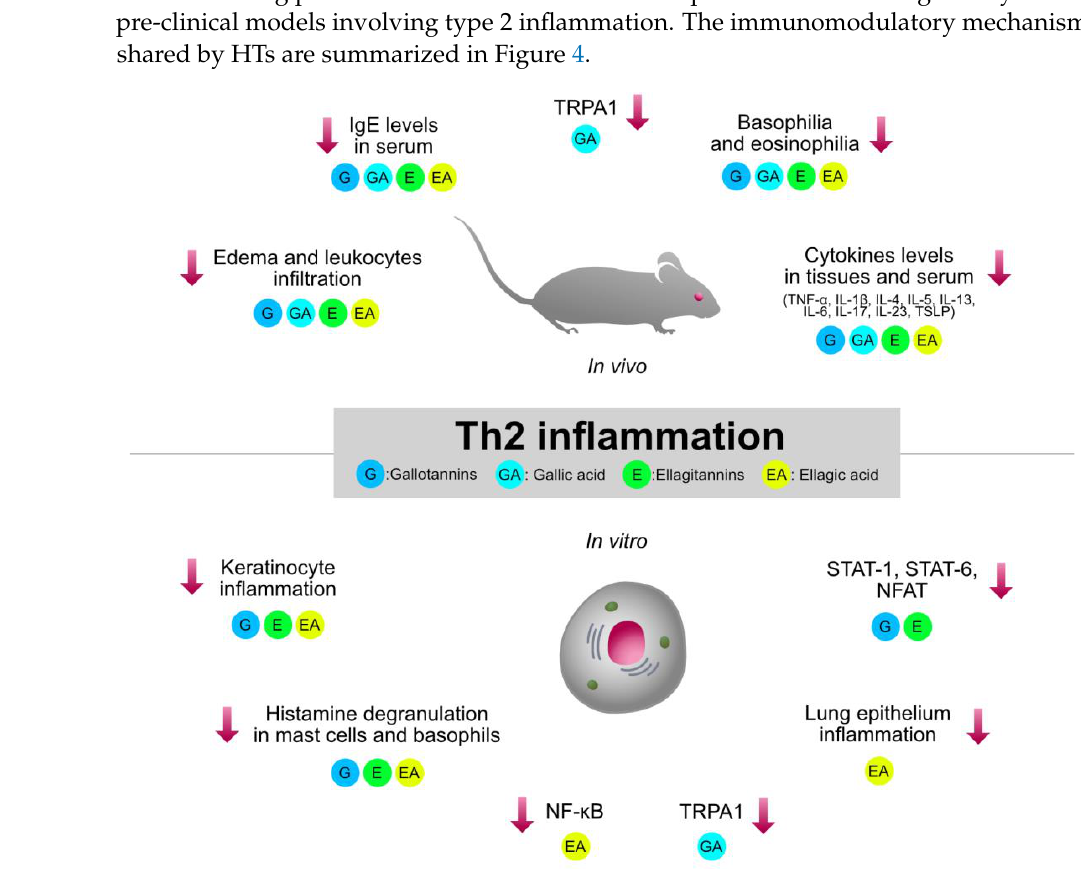
Figure 4. Graphical summary of the anti-inflammatory mechanisms of HTs and their hydrolysis derivatives (GA, EA), investigated in type 2 inflammation models (asthma, AD, allergic rhinitis). The compounds share immunosuppressive properties on innate cytokines (TNF- α, IL - 1β, IL -6) and type 2 cytokines (TSLP, IL-4, IL-5, IL-13), which are modulated by the NF- κB and STAT pathway s. G, gallotannins; E, ellagitannins; GA, gallic acid; EA, ellagic acid. Red arrows indicate inhibition.